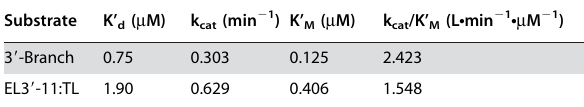
Table 2. Kinetic parameters of Rnt1p cleavage of inter- and